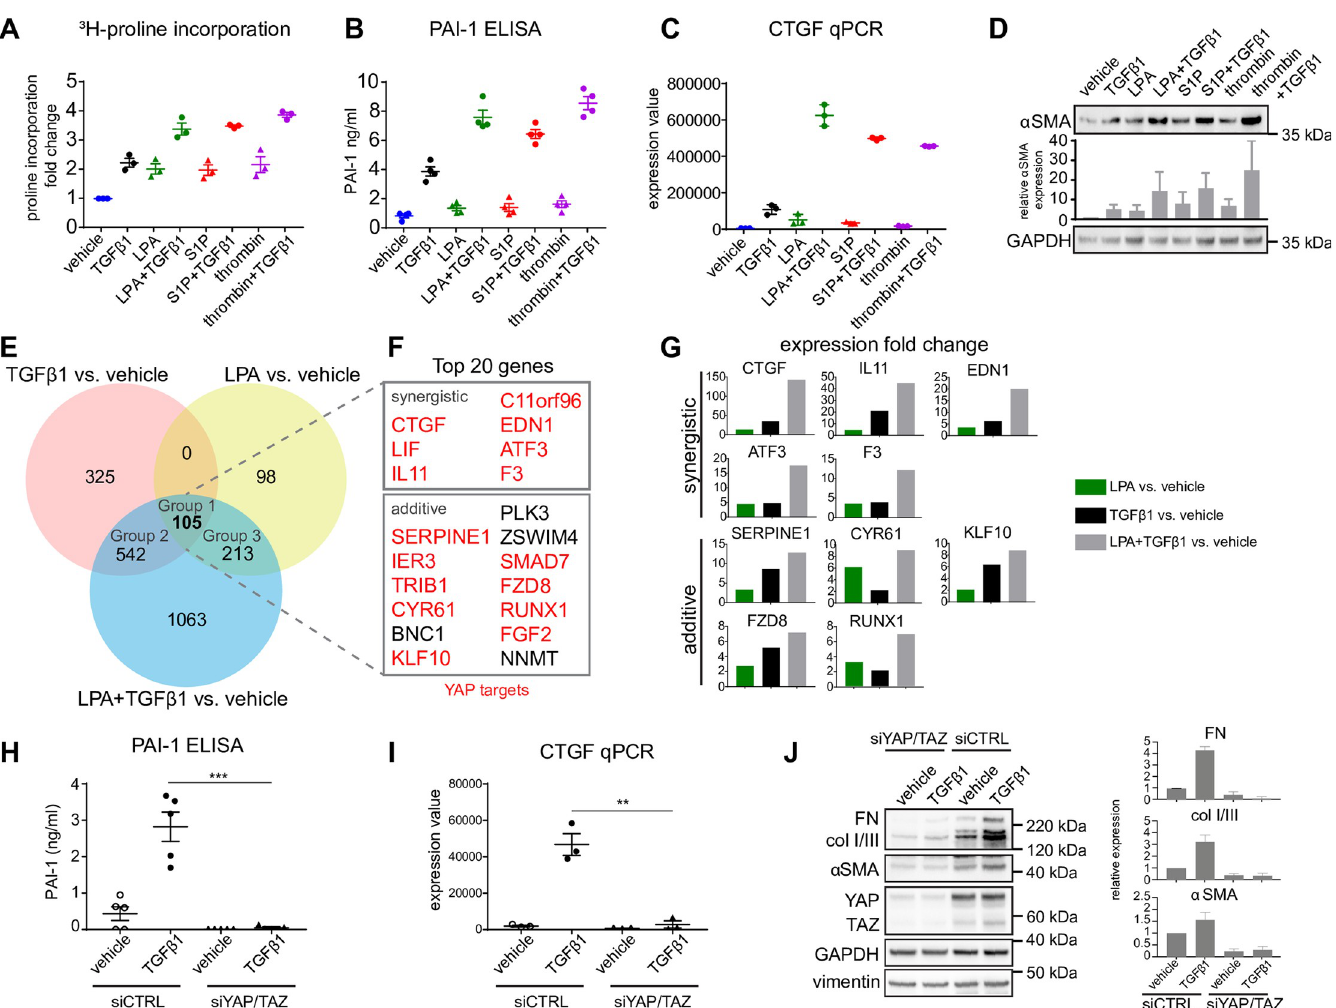
Fig 1. GPCR ligands and TGF β 1 cooperate to induce a profibrotic phenotype and YAP/TAZ target gene expression in NHDF. (A, B) NHDF were starved and stimulated with 5ng/ml TGF β 1, 1 μ M LPA, 1 μ M S1P, 1mU/ml thrombin alone or in combination for 24h. ECM synthesis was measured by 3 H-proline incorporation (n = 3) and PAI-1 in the cell supernatant was determined by ELISA (n = 4). Mean+/- SEM. (C) NHDF were treated as in A for 3h. CTGF expression was determined by RT-qPCR (n = 3). Mean+/- SEM. Statistics for A-C are summarized in S6 Table. (D) NHDF were treated as in A. Levels of α SMA were determined by western blot. GAPDH served as loading control. The signal for α SMA was measured by image densitometry and expressed as relative value compared to vehicle-treated sample (n = 4). Mean+/- SEM. (E) Whole genome expression analysis of NHDF treated for 3h as indicated. Graphical representation of the Venn diagram analysis results. (F) Top 20 upregulated genes (when ordered by log2FC in the TGF β 1/LPA vs vehicle contrast) from Group 1 are depicted and classified for synergistic or additive effects of the TGF β 1/LPA combination. Genes highlighted in red represent YAP/TAZ target genes. (G) Graphs showing gene expression fold change values for selected genes from G for the indicated contrasts. (H) NHDF were transfected with control siRNA (siCTRL) or siRNAs against YAP/TAZ, starved and stimulated with 5ng/ml TGF β 1 for 24h. PAI-1 in cell supernatant was determined by ELISA (n = 5). Mean+/- SEM. (I) NHDF were treated as in H for 3h. CTGF gene expression was measured by RT- qPCR (n = 3). Mean+/- SEM. (J) NHDF were treated as in C. Levels of FN, collagen I/III, α SMA, YAP and TAZ were determined by western blot. GAPDH served as loading control. Images are representative of 3 independent experiments. Right panel shows results of image densitometry. FN, collagen and α SMA were normalized to the loading control. Relative expression to siCTRL vehicle samples are shown. n = 4, mean +/-